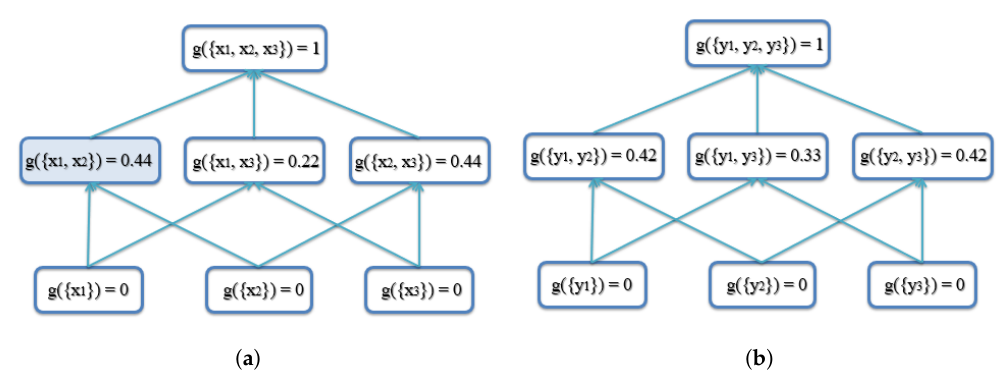
Figure 6. Lattice of the FM of agreement for the first example of three similar AABBs. See the text for an example of how to calculate g ( { x 1 , x 2 } ) . ( a ) Lattice of the FM of agreement on the x-axis for the first example; ( b ) lattice of the FM of agreement on the y-axis for the first